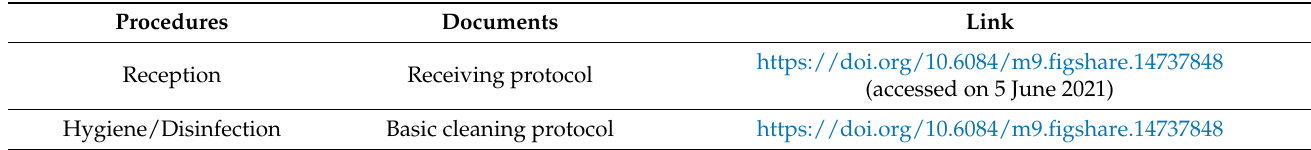
Table A1. Procedures, documents, and